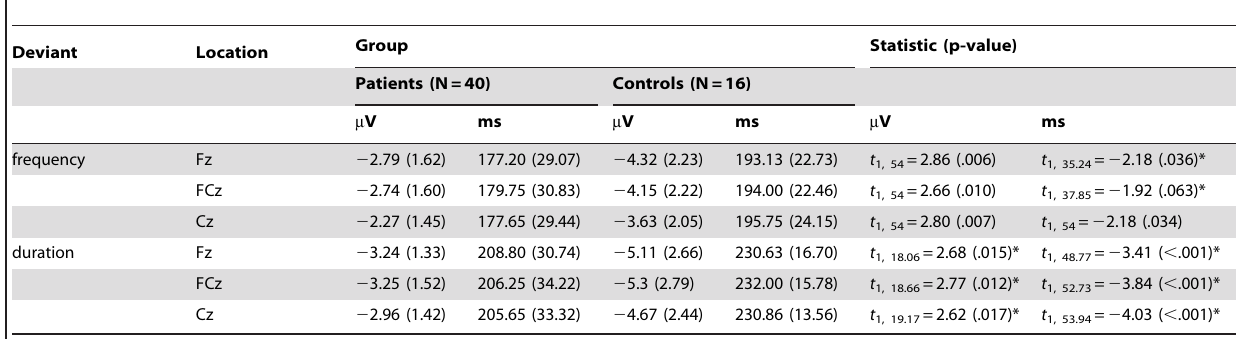
Between-group t-statistics (p-values) are reported for amplitude ( m V) and latency (ms) separately for each electrode. Adjusted t-statistics (Welch-test) are reported (*), in the case of unequal variances.